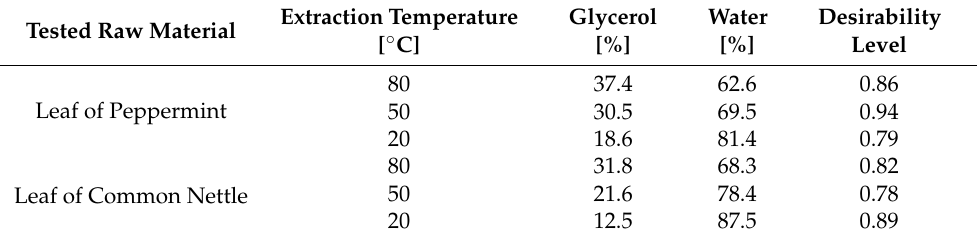
Table 6. Optimum conditions of extraction with a glycerol:water mixture and the level of